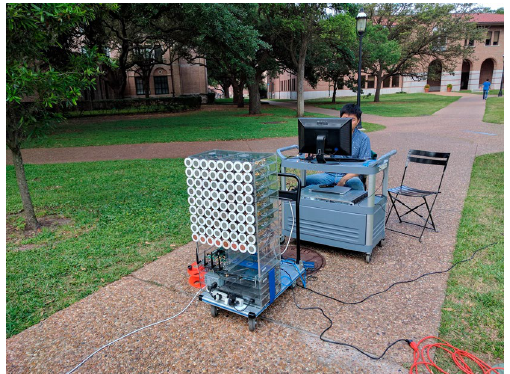
Fig. 2 Channel measurements setup with large-array base-station. The plot comes from